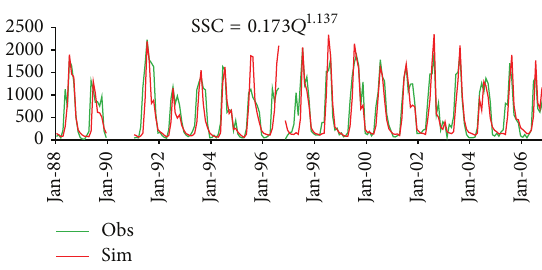
Figure 4: Comparison of monthly observed SSC and simulated SSC from common sediment rating curve.